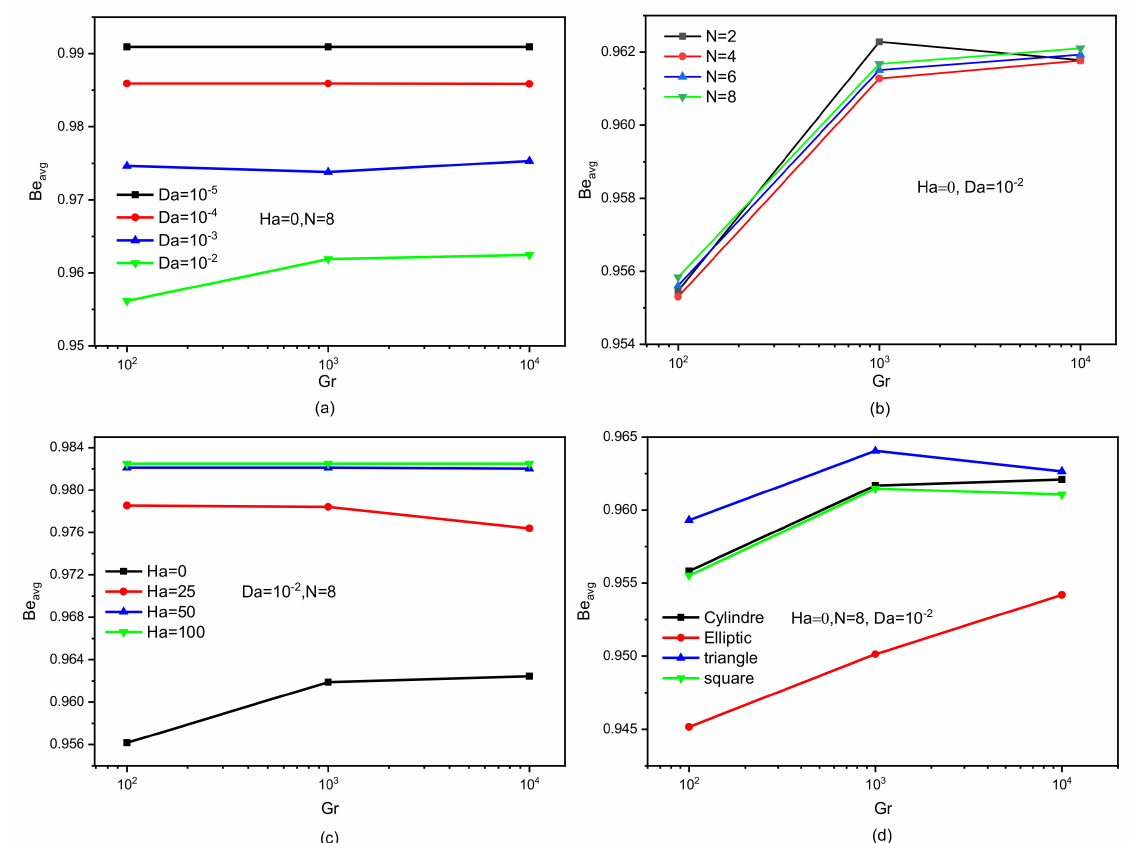
Figure 9. Bejan number versus Grashof numbers for different ( a ) Darcy numbers, ( b ) undulation numbers, ( c ) Hartmann numbers, and ( d ) obstacle shapes for Da = 10 − 2 , Ha = 0, and N =